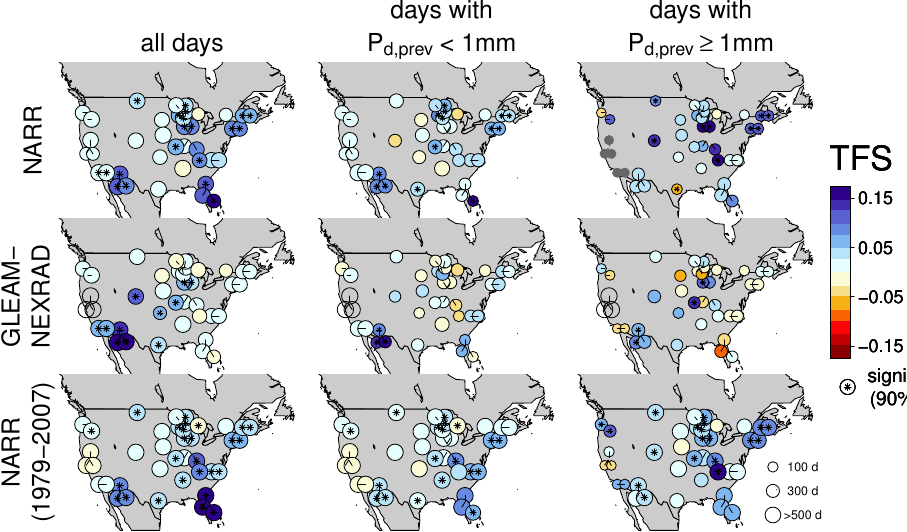
Figure 8. TFS ∗ for subset of days: (left) all days and (center) days without and (right) days with rainfall on the previous day to account for precipitation persistence. Top row: NARR (years 1995–2007, as in the rest of the analysis). Middle row: GLEAM–NEXRAD combination. Bottom row: NARR, all years (1979–2007) for comparison, as the conditioning on previous-day precipitation reduces the number of days available for the computation. The size of the dots indicates the number of days included in the computation according to the legend shown on the bottom right map. Empty dots indicate sites with unreliable NEXRAD